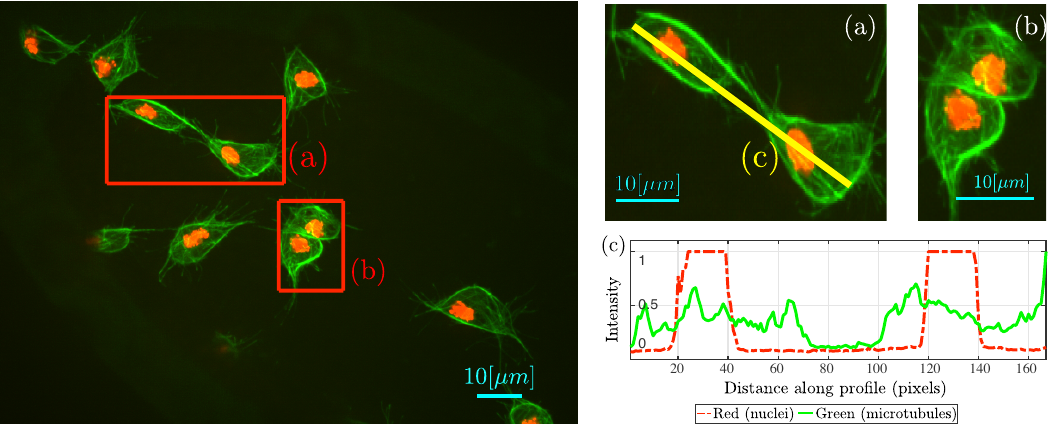
Figure 2. Representative time frame highlighting in red ( a , b ) the interactions between cells; ( c ) Shows the intensities for the red and green channel along an image profile (yellow, solid). Detail of the highlighted pairs of cells, ( a , b ) are shown. ( a ) Notice the arm-like microtubular structures in green, identified in [8] as moments before a change in trajectories. A bigger portion of the cells are in contact in ( b ), showing and example where cell–cell contact occurs over several frames. Bars 10 µ